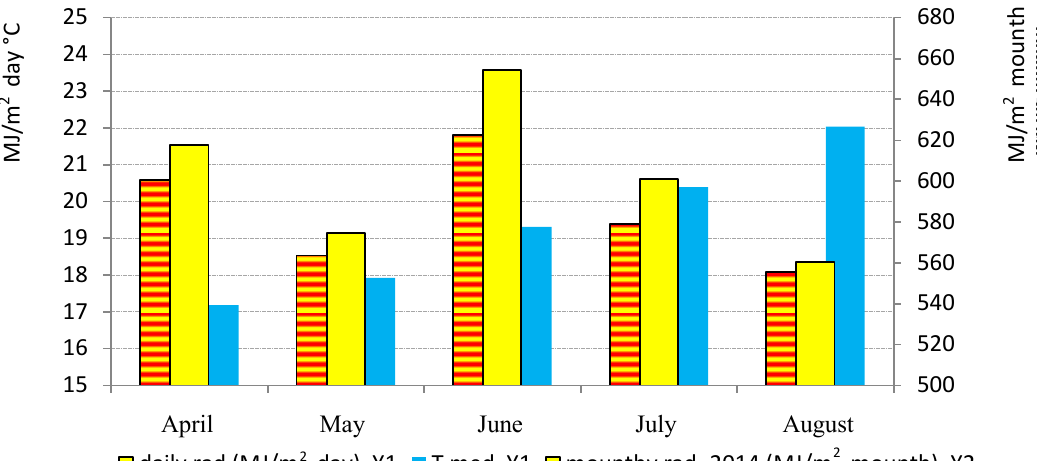
Figure 1. During the previous 14 years, the average values of the minimum and maximum temperatures were 11 °C and 31 °C, respectively. The field is classified as Anthrosol [8] or Torriarent [9].